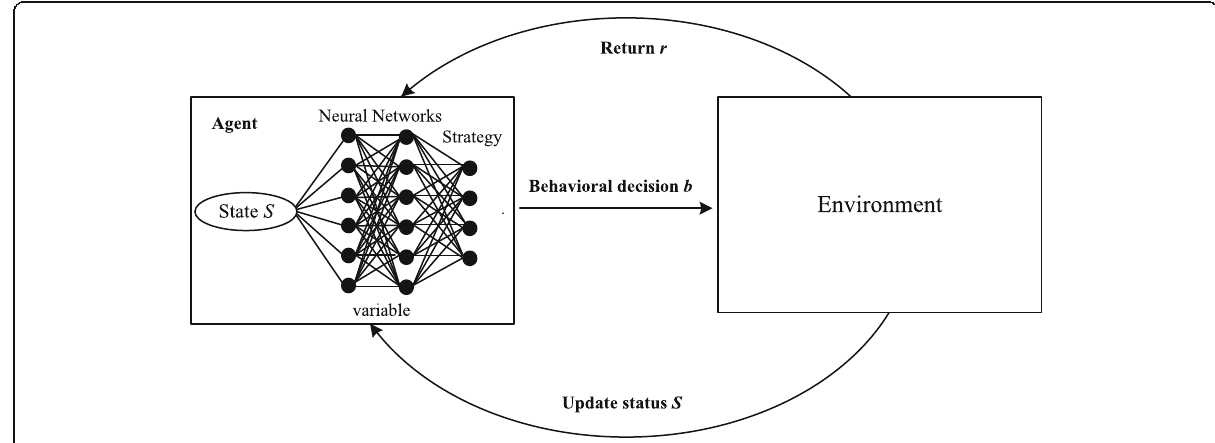
Fig. 4 Interaction block diagram of reinforcement